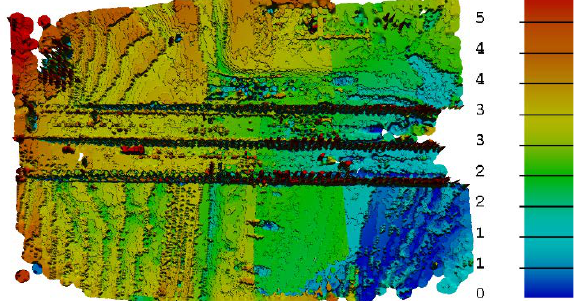
Figure 8. Difference map for target